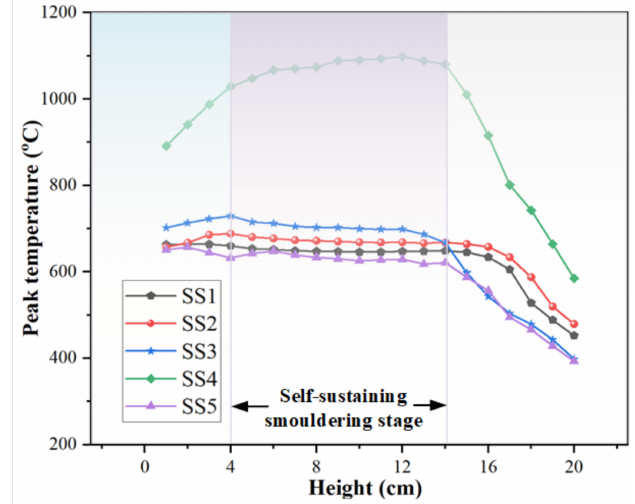
Figure 8. Central peak temperature histories of smoldering experiments.